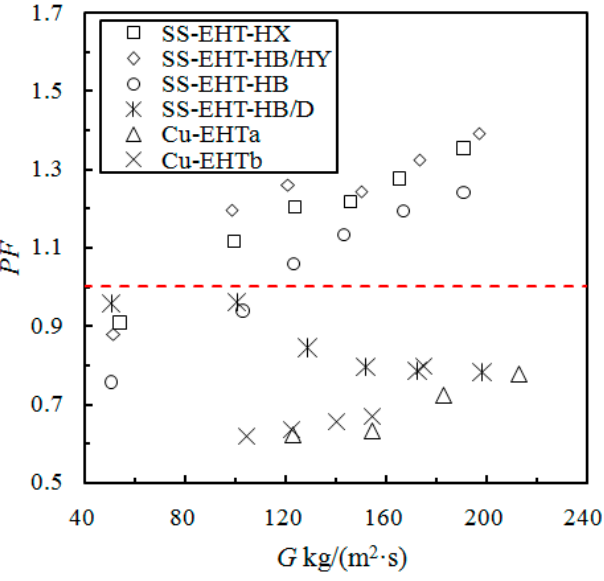
Figure 6. Comparison of the evaporation heat transfer performance factors (PF) of evaporation heat transfer in the enhanced tubes.